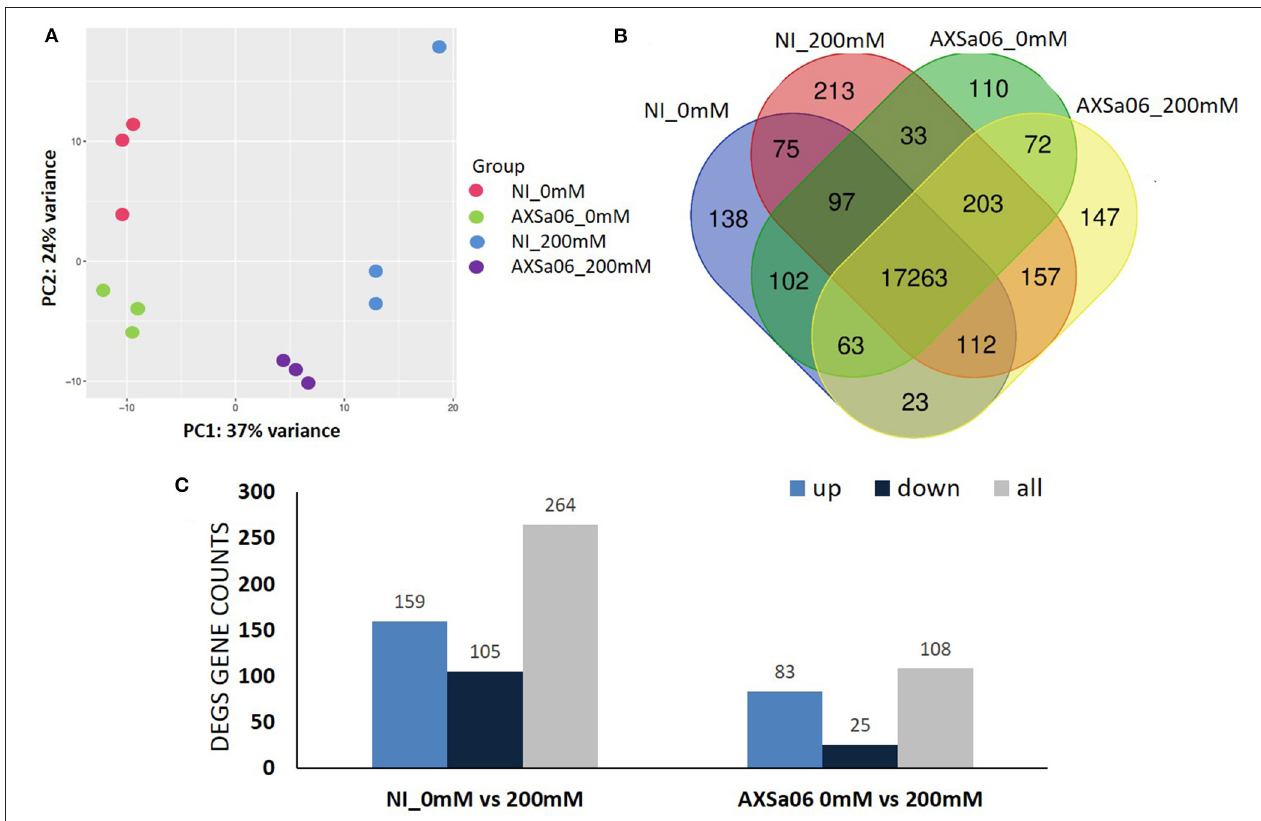
FIGURE 4 | (A) Principal Component analysis of all the expressed transcripts with FPKM > 1 in non-inoculated (NI) and AXSa06-inoculated plants treated with 0mM or 200mM NaCl. (B) Venn diagram of the expressed transcripts with FPKM > 1 highlighting commonly and uniquely expressed genes between different treatments. (C) The number of Differentially Expressed Genes (DEGs) representing up- and down-regulated transcripts in non-inoculated and inoculated plants due to NaCl